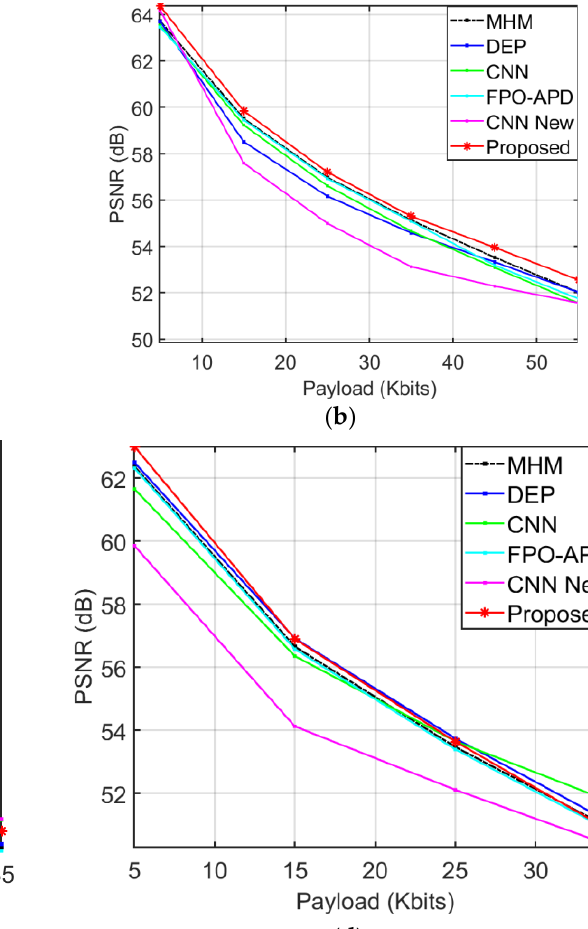
Figure 5. Comparison of image quality for individual typical test images: ( a ) Lena, ( b ) Tiffany, ( c ) Boat, and ( d ) Tank. Table 1. Comparison of average PSNRs (dB) with different parameter configurations. The best per- formance is marked in bold.